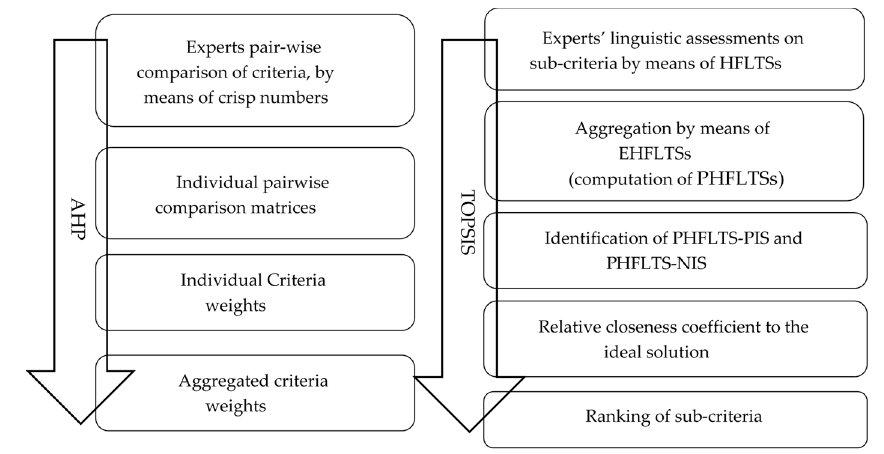
Figure 2. A framework for GDM with linguistic information provided by experts.